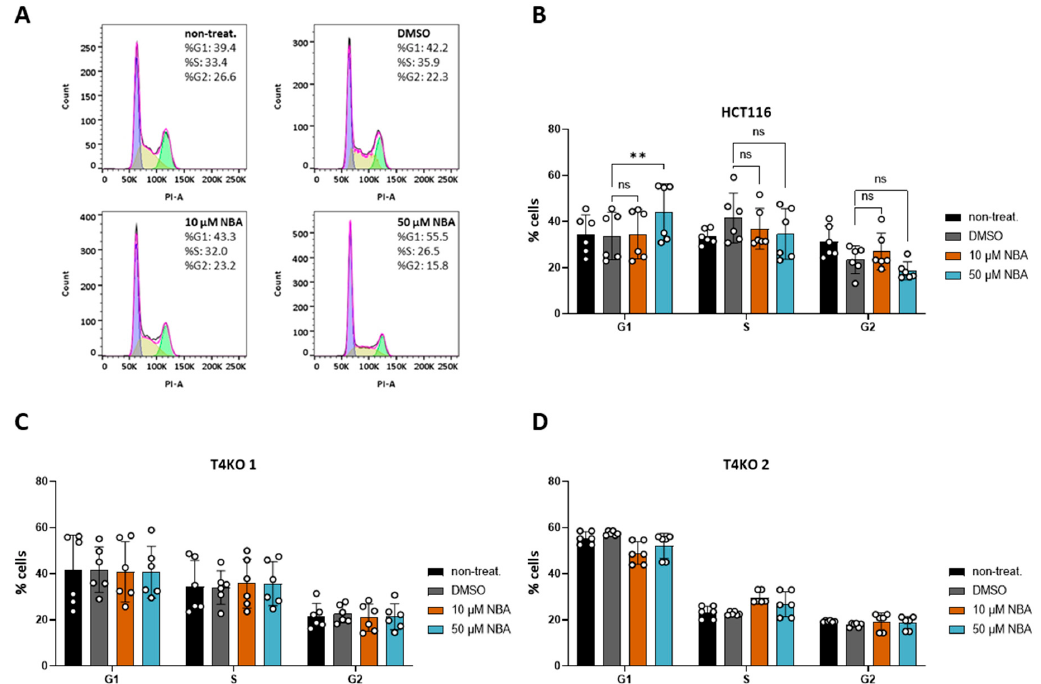
Figure 5. Effect of NBA on cell cycle in HCT116 and T4KO cells. FACS-based cell cycle analysis. The experiment was repeated four times with from one to two replicates in each experiment. ( A ) Representative histograms of PI staining in HCT116 without inhibitor treatment, treated with DMSO and treated with 10 µM and 50 µM NBA, with cell distribution in % for one specific measurement. ( B ) Scatter plot and bar diagram (mean + SD) for cell cycle distribution of HCT116 without inhibitor treatment, treated with DMSO and treated with 10 µM and 50 µM NBA. ( C ) Scatter plot and bar diagram (mean + SD) for cell cycle distribution of T4KO 1 without inhibitor treatment, treated with DMSO and treated with 10 µM and 50 µM NBA. ( D ) Scatter plot and bar diagram (mean + SD) for cell cycle distribution of T4KO 2 without inhibitor treatment, treated with DMSO and treated with 10 µM and 50 µM NBA. One-way ANOVA was used to determine statistical significance (** p < 0.005, ns—non significant) in ( B – D ).